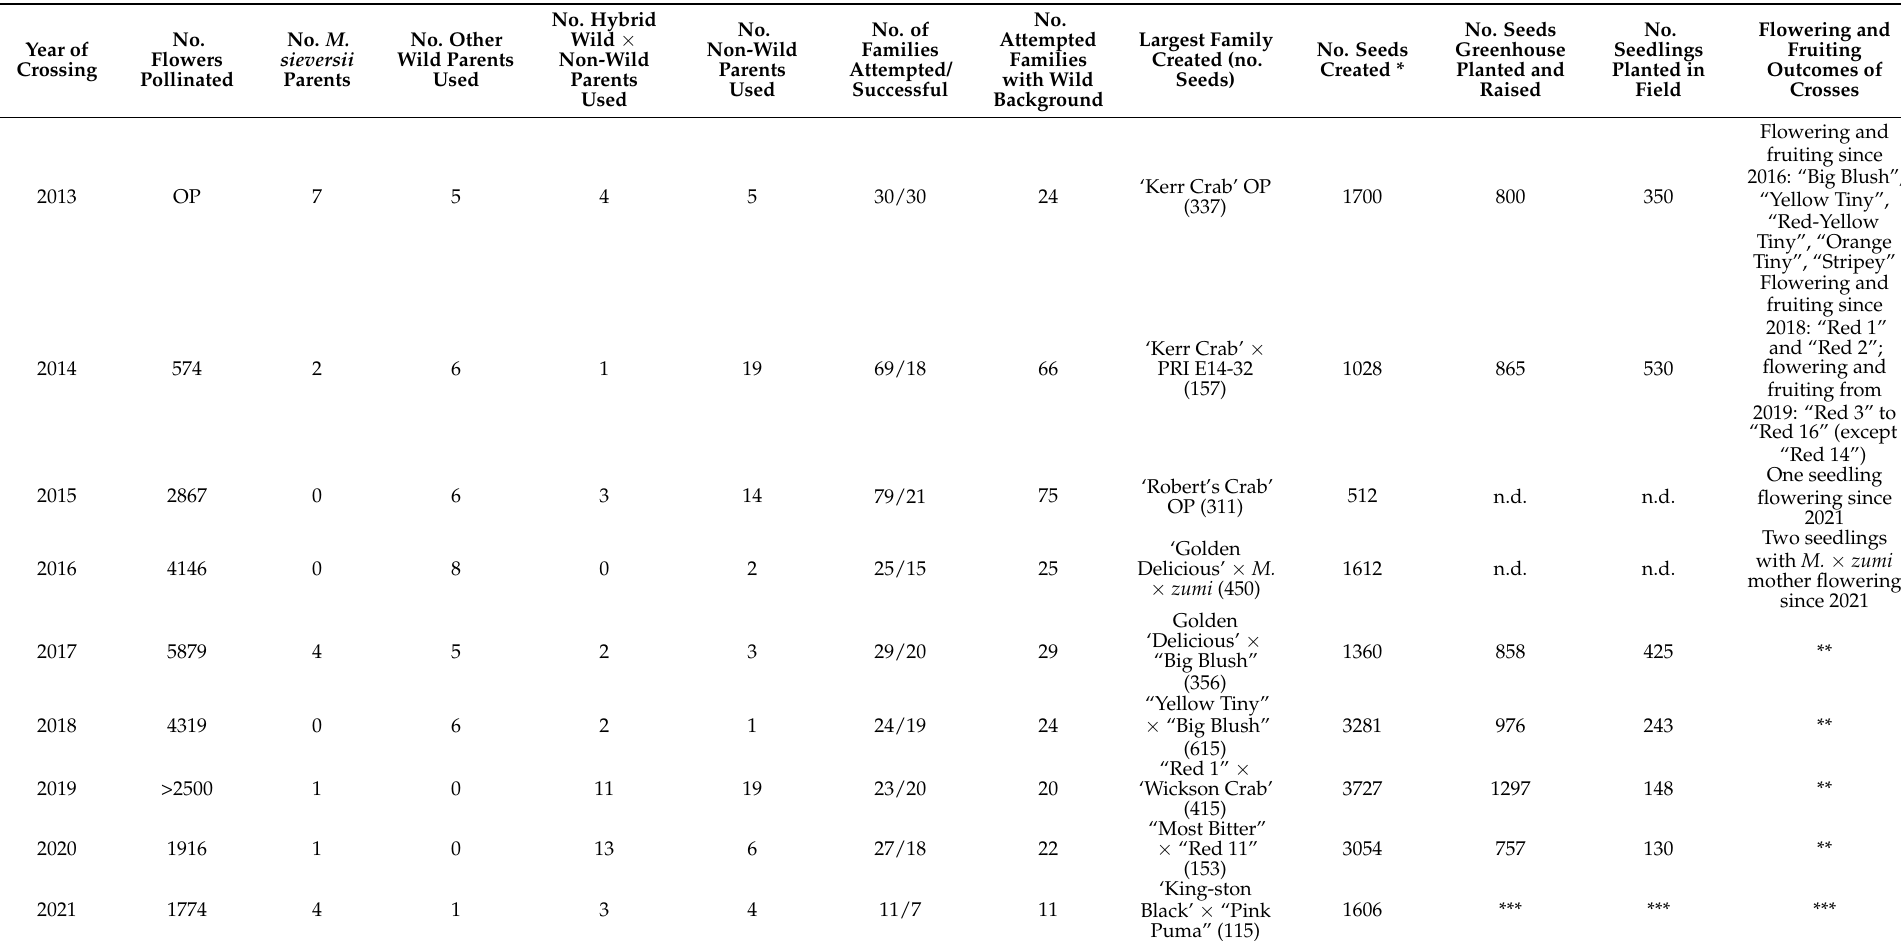
Table 2. Number of flowers pollinated including wild-background parents used, largest family created, and highlighted outcomes from crosses for 2013–2021. OP